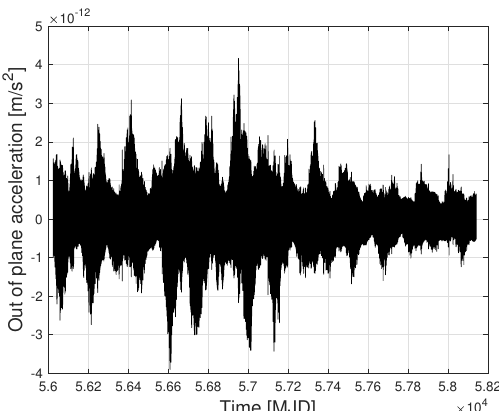
Figure 6. Out-of-plane acceleration [m/s 2 ] on LARES due to the neutral drag perturbation as computed with SATRAP in the case of the MSIS-86 atmospheric model.